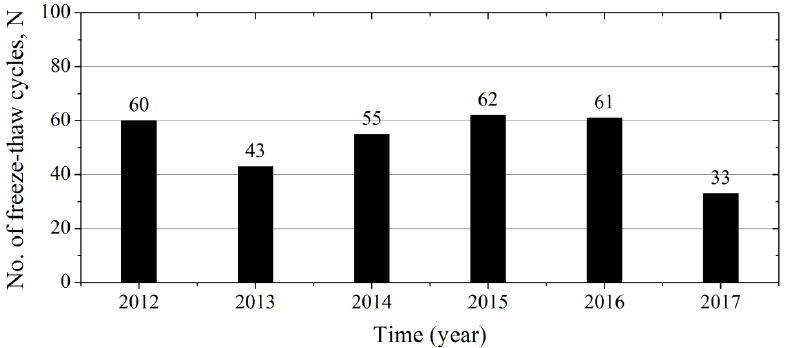
Figure 3. Number of freeze-thaw cycles in terms of minimum and maximum daily air temperature measured at Dasan station at Ny-Ålesund.